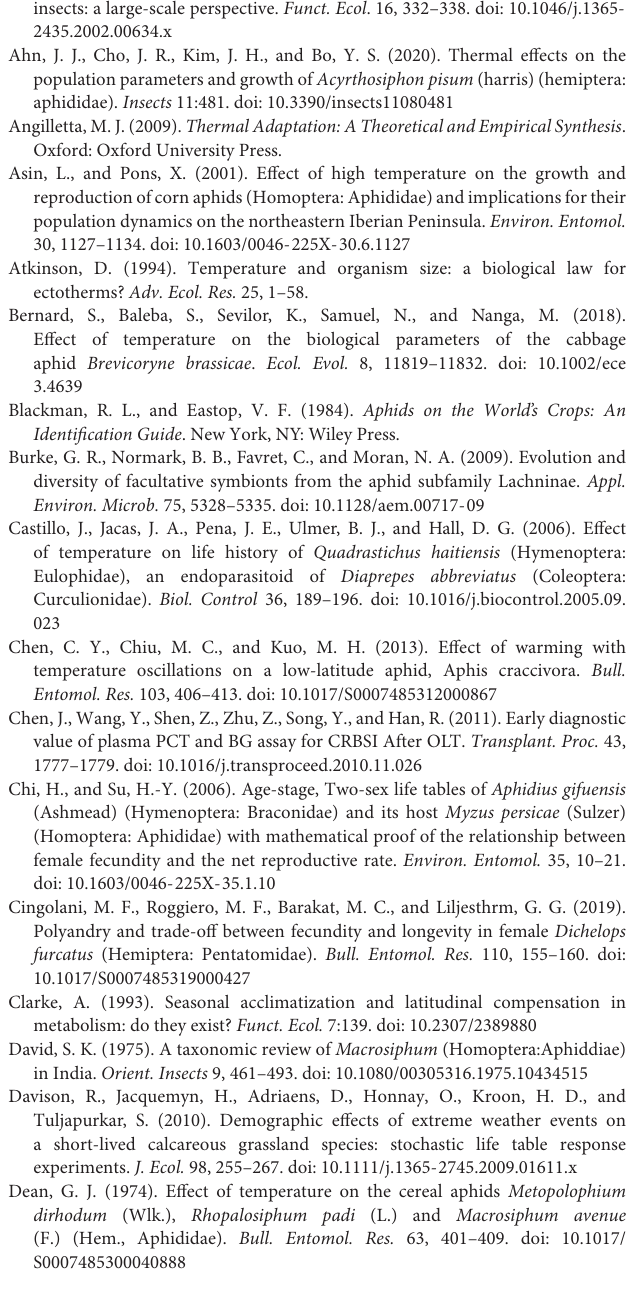
Frontiers in Ecology and Evolution |